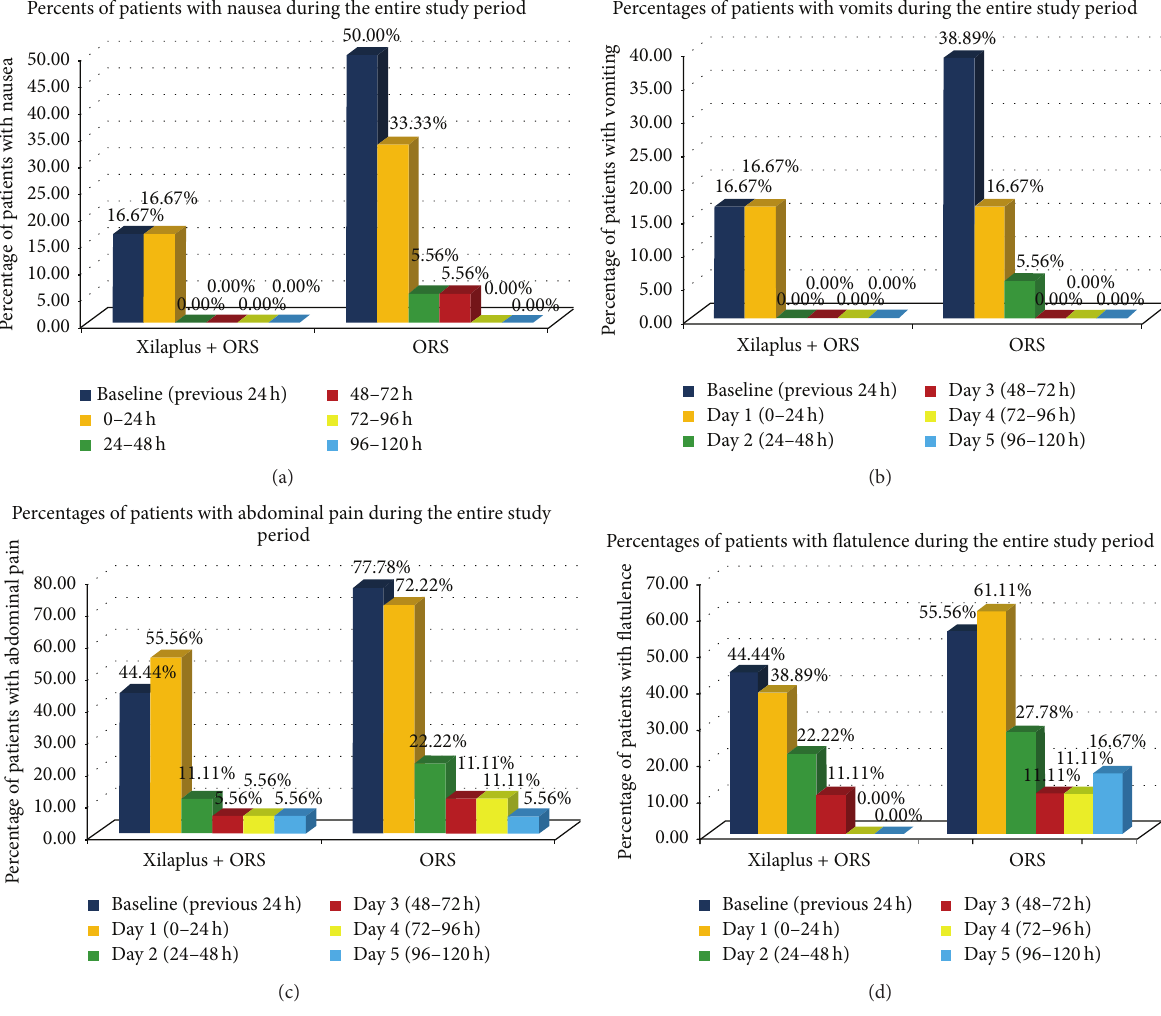
Figure 2: Evolution of clinical symptoms of gastroenteritis during the study period in both groups. (a) Evolution of the percentage of patients with nausea. (b) Evolution of the percentage of patients with vomiting. (c) Evolution of the percentage of patients with abdominal pain. (d) Evolution of the percentage of patients with